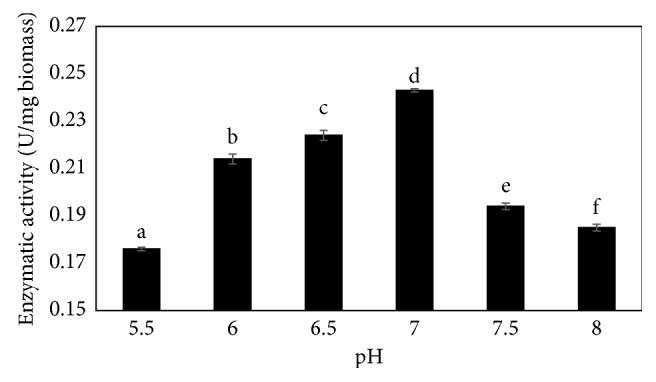
The effect of pH on glucose isomerase production. In this study, we observed an increase of enzyme activity (0.176 ± 0.01 to 0.243 ± 0.01 U/mg biomass) along with an increase of pH value of induction medium (pH 5.5–pH 7.0). However, when pH increased from 7.5 to 8.0, we observed a decline of enzyme activity (from 0.194 ± 0.01 to 0.185 ± 0.01 U/mg biomass, resp.). From these data, we chose optimal pH value for glucose isomerase production was 7.0. a, b, c, d, e, and f indicate the significant difference between groups.